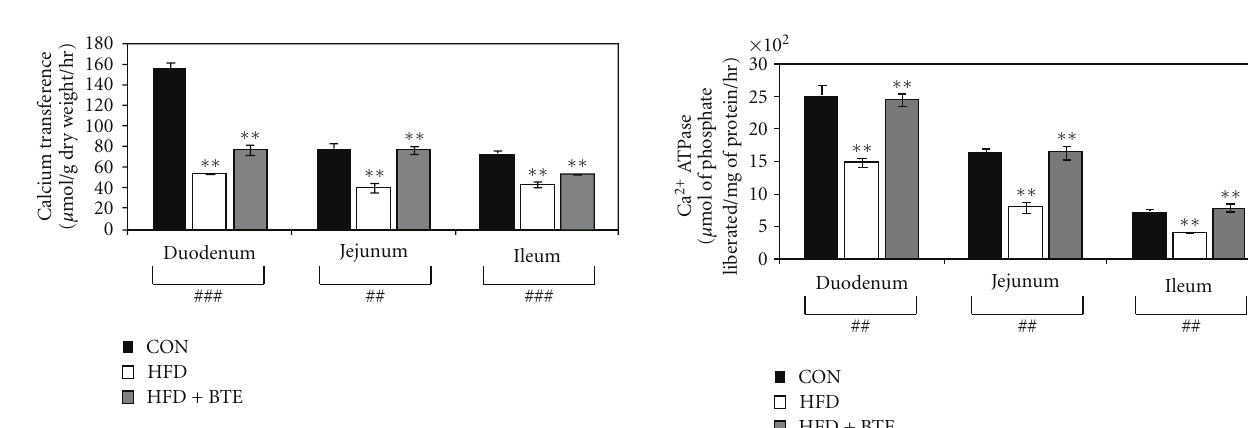
Figure 4: Transference of calcium in duodenal, jejunal, and ileal segments of control (CON; Group A), HFD treated (Group B), and HFD + BTE supplemented (Group C) groups of rats. Values are expressed as mean ± S.E.M. ( n = 6). ### and ## denote significance level P < . 001 and P < . 01, respectively, based on Kruskal-Wallis nonparametric ANOVA test and ∗∗ P < . 01 denotes significance level based on Mann-Whitney “U” multiple comparison test.